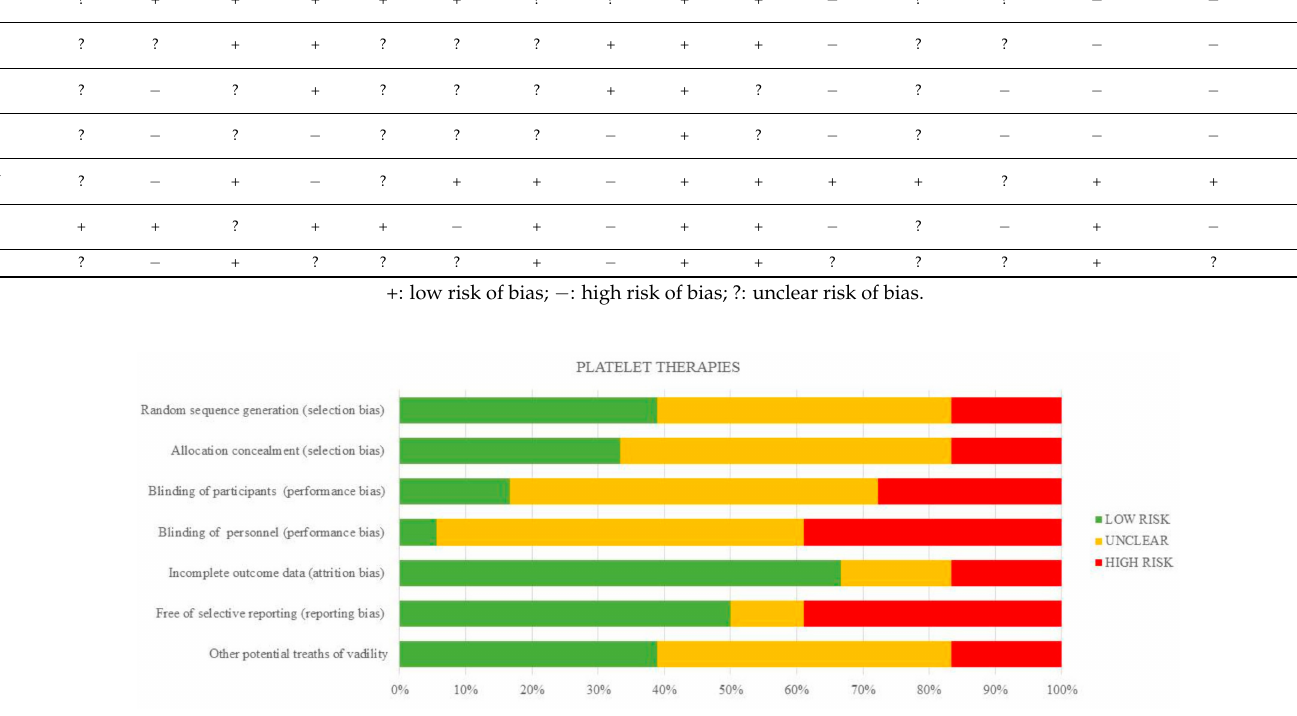
Figure 2. Quantification synthesis of risk of bias (platelet